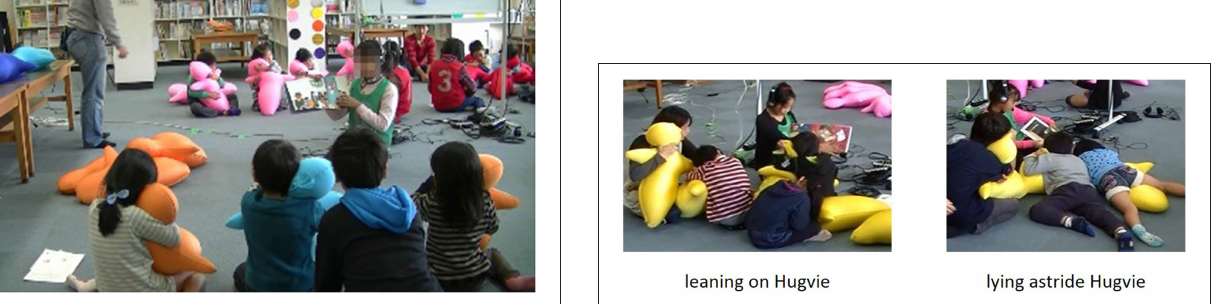
FIGURE 6 | Simultaneous storytime in children